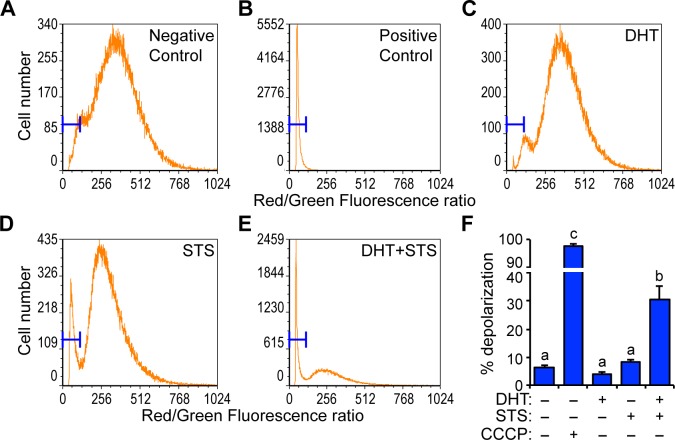
Androgen and staurosporine synergize to induce mitochondrial depolarization in HPr-1AR.(A-E) HPr-1AR cells were treated with 10 nM DHT or vehicle control for 20 hours and then co-treated with 2 μM STS or vehicle control for 4.5 hours. Cells treated with vehicle control were used as the negative control. In addition, 2 μM CCCP was added to an aliquot of the negative control cells to depolarize their mitochondria and generate the positive control. Cells were stained with JC-1 dye and analyzed using flow cytometry. For each treatment, the ratios of red to green fluorescent intensities are displayed in histograms. Blue brackets at the left of each panel specify the population of cells with depolarized mitochondria. Normal cells (A) have a wide and bell-shaped distribution of JC-1 stained mitochondria, whereas cells with depolarized mitochondria have a sharp and left-shifted distribution (B). (F) Quantification of the depolarized cell proportion for each treatment revealed that DHT or STS alone do not significantly increase mitochondrial depolarization. However, co-treatment with DHT and STS significantly increases the depolarized population by 4-fold or more. Data represent the mean ± SEM (n = 4). Comparisons between different treatments were performed using two-way ANOVA followed by Tukey’s honest significant difference test.